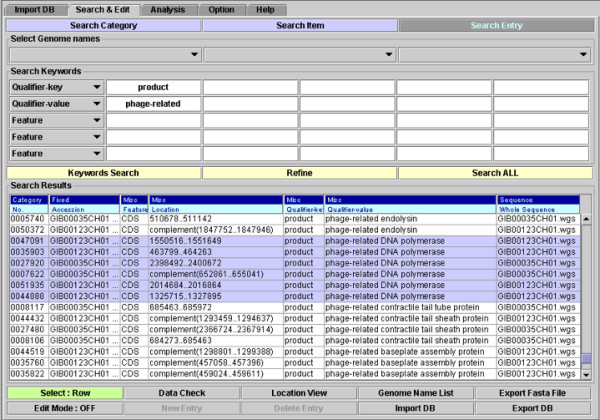
G-InforBIO database screen. The genome information database screen is shown. Details of the keyword searches are described in the text. Lines, including phage-related DNA polymerase, are selected by clicking in the database (as shown by violet), and their protein sequences were transferred to ClustalW as described in text.